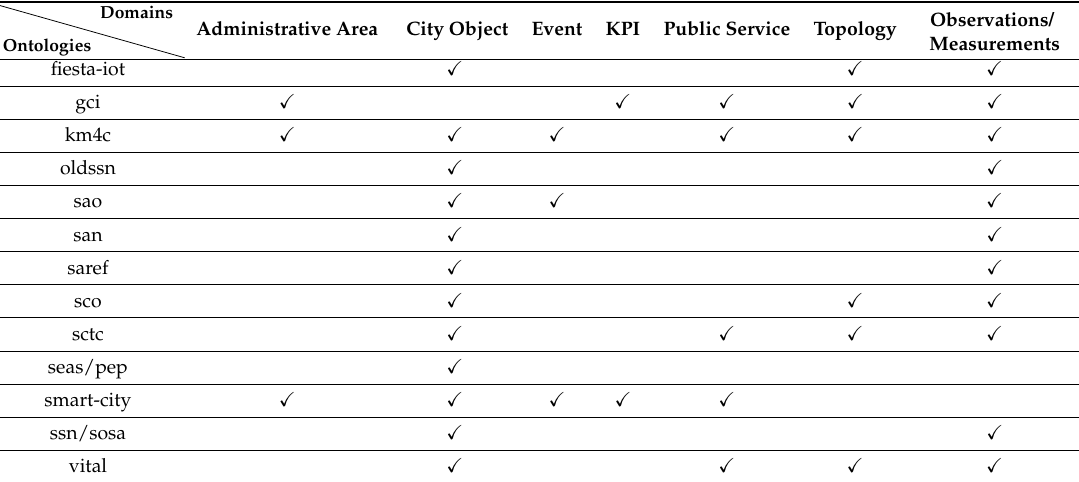
Table 5. Domains represented in smart city